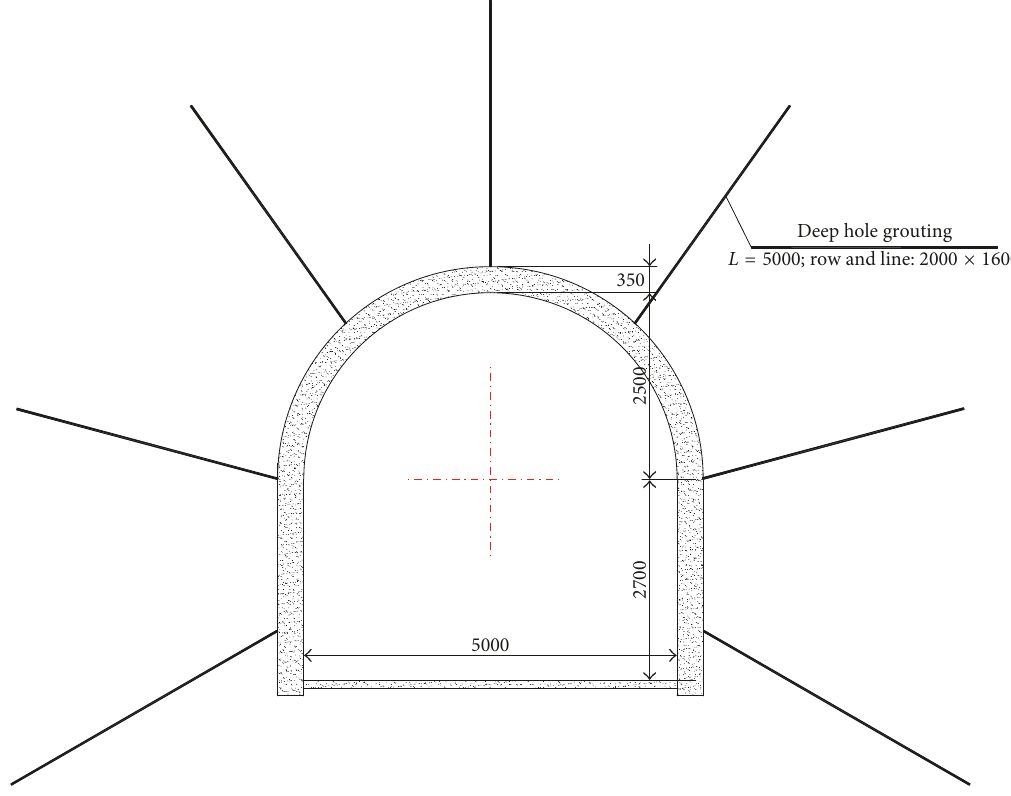
Figure 12: Pregrouting design (unit: